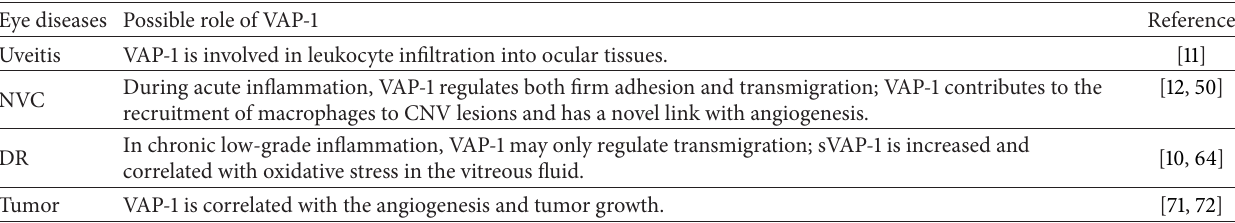
Table 1: The function of vascular adhesion protein-1 in ocular